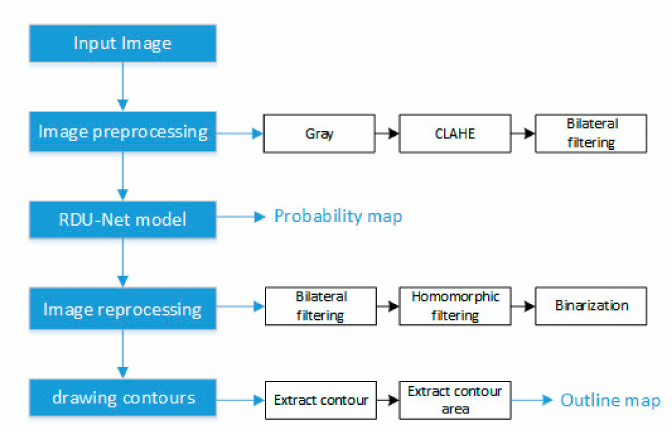
Figure 7. Algorithm